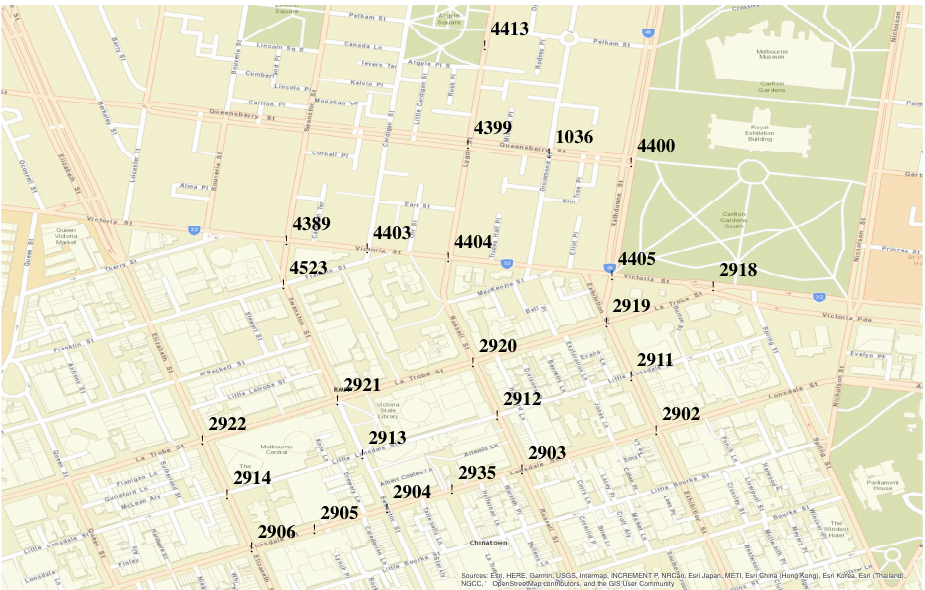
Figure 4. Area selected for the case study with traffic count locations.